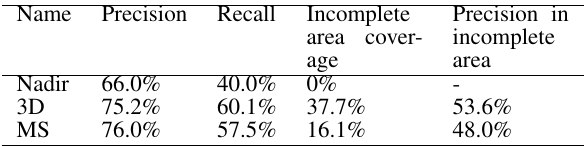
Table 1. Quantitative comparison of the DIM cloud from all flight paths